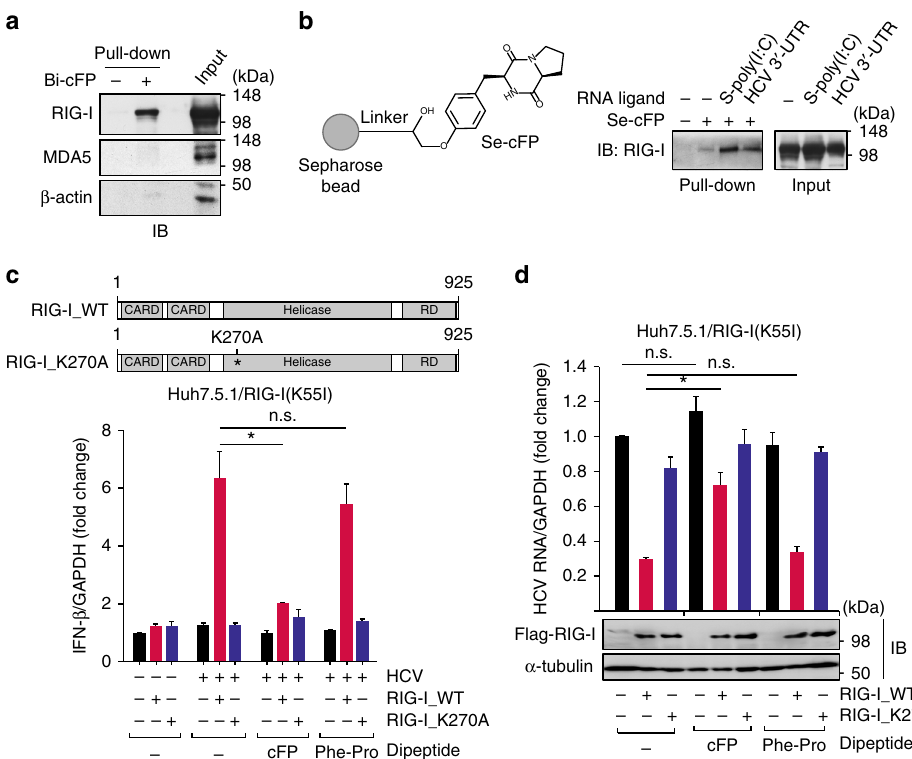
Fig. 3 HCV-promoting activity of cFP is mediated through its speci fi c interaction with RIG-I. a , b Immunoblotting analysis of cFP-interacting proteins pull- downed by biotinylated cFP bound to Streptavidin beads ( a ) or by non-modi fi ed cFP immobilized onto Sepharose beads ( b ). HEK293T cells, which were non-stimulated ( a ) or stimulated with the indicated RNA ligands ( b ) were used in pull-down experiments. c , d Quanti fi cation of IFN- β mRNA ( c ) and HCV genome ( d ) levels in Huh7.5.1 cells transfected with an empty vector or a vector expressing the wild-type RIG-I (RIG-I_WT) or its inactive mutant (RIG- I_K270A). After 18 h, the transfected cells were infected with HCV (JFH1) by incubation for 6 h and incubated further for 24 h in fresh media without or with the indicated peptides (2.5 mM) prior to RT-qPCR analyses. Statistical signi fi cance of differences between groups was determined via unpaired two- tailed t -test. * P ≤ 0.05; n.s., not signi fi